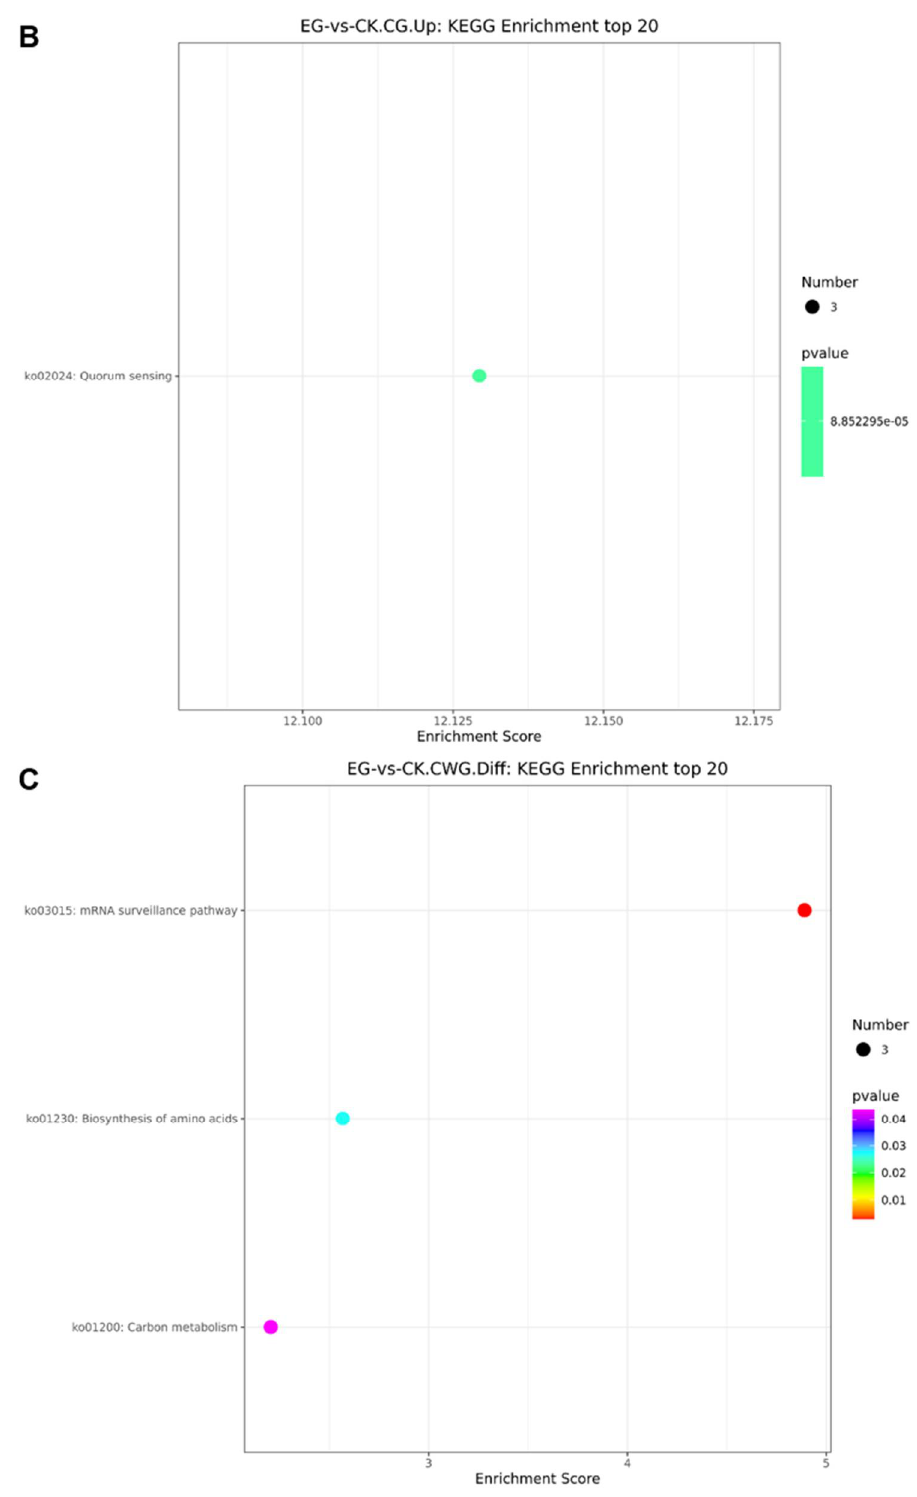
Figure 10. The top 20 KEGG enrichment analyses of the genes where the CG and CWG differential methylation sites are located. ( A , B ) Differential KEGG enrichment at the CG methylation level. ( C ) Differential KEGG enrichment at the CWG methylation level. The x -axis is the enrichment score, and the y -axis is the KEGG enrichment. The bubble represents gene entries; the larger the bubble, the more entries it contains and the more differential protein-coding genes. The bubble color changes from purple-blue-green-red, denoting a p-value and the smaller the enrichment value, the greater the significance.